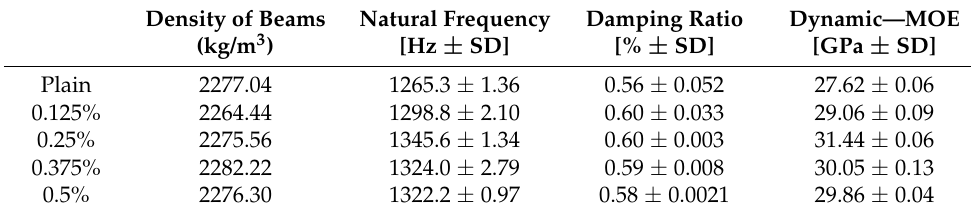
Table 7. Dynamic MOE of each mix in the modal